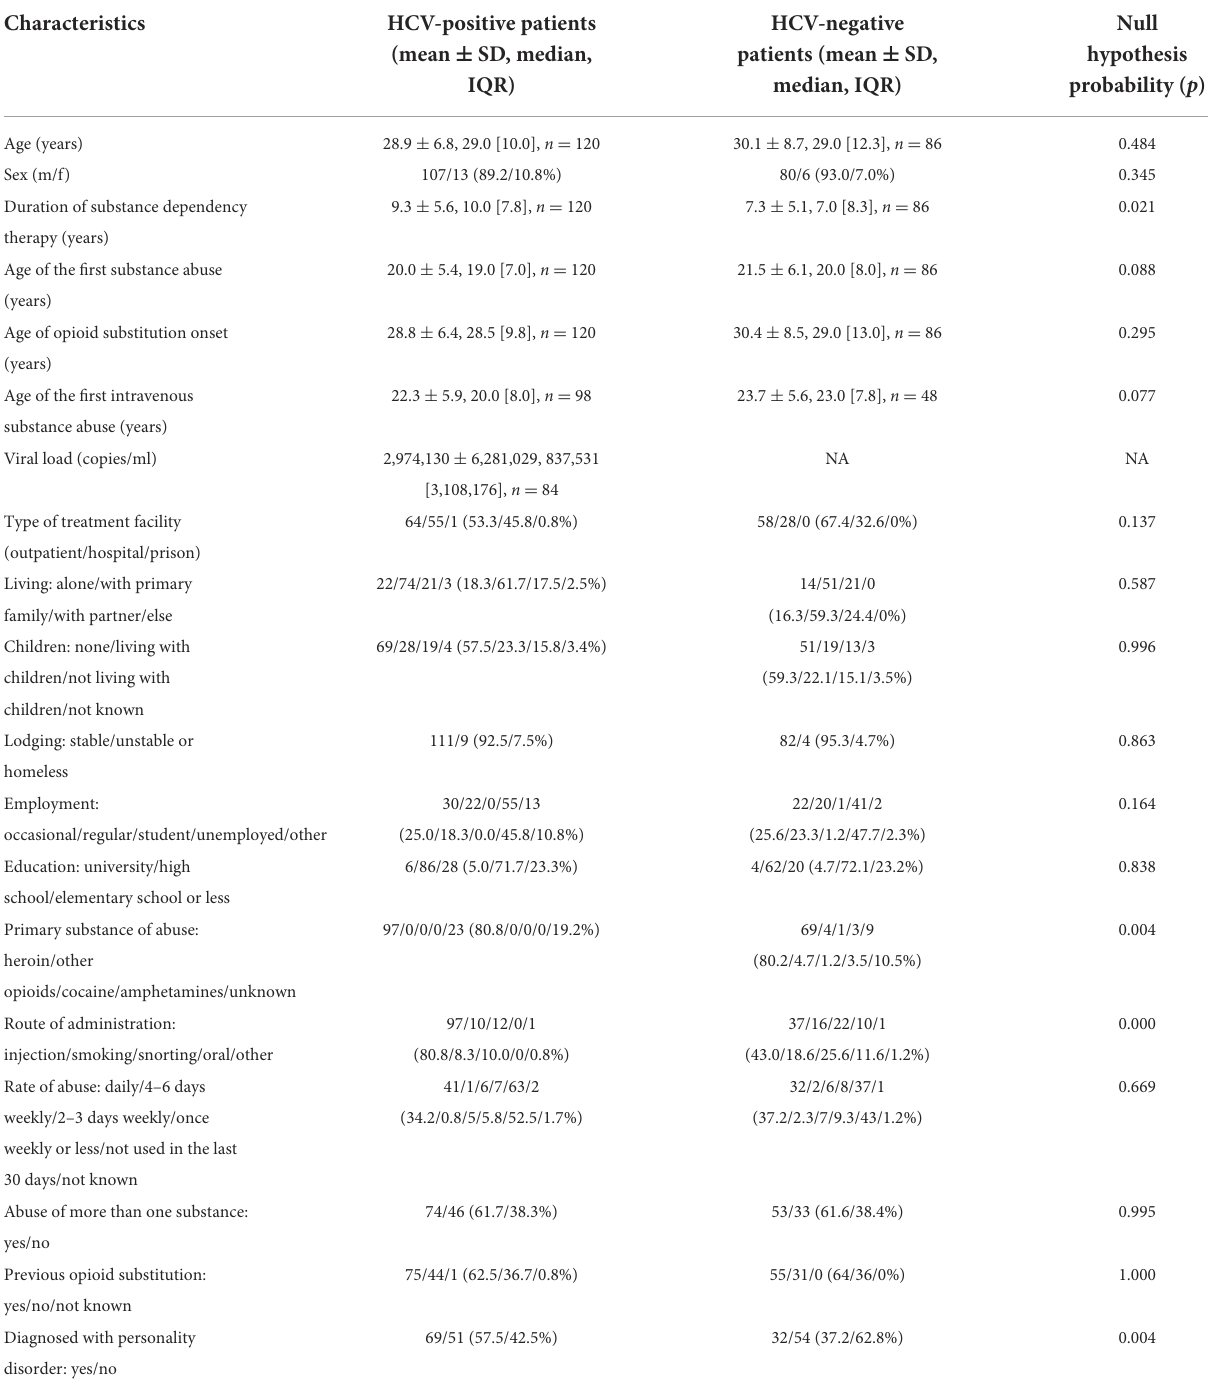
TABLE 1 Characteristics of patients according to HCV status.